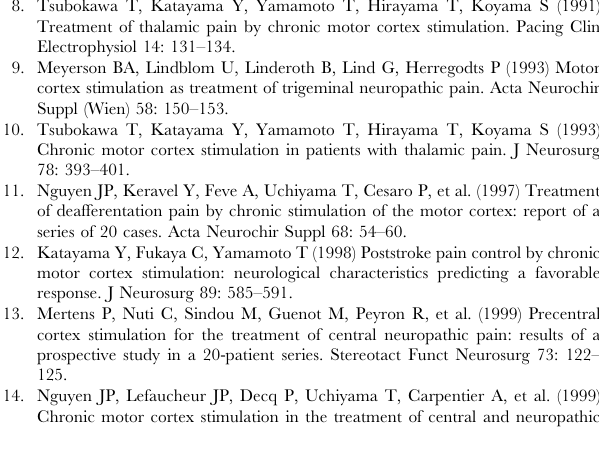
response would have occurred. Figure S3 C-fiber EFPs. A, averaged C-fiber EFPs (top traces) produced by two stimulating electrodes located 3 cm apart on the sciatic (SN) and sural (SU) nerves. The drawing shows the relative positions of the electrodes. Notice the similarity of the two responses. B, relationship between the stimulation intensity and